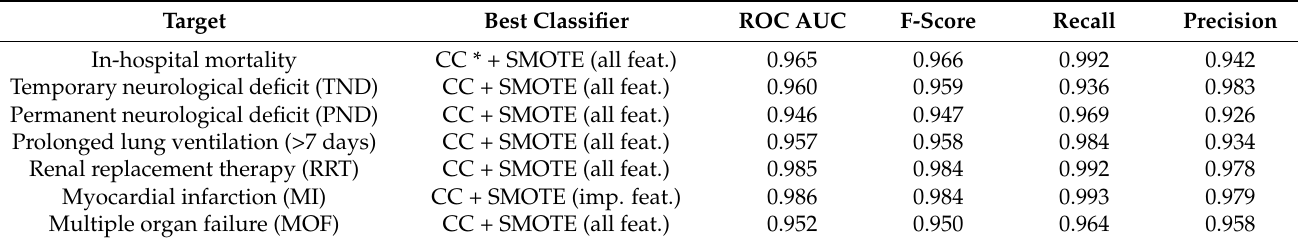
Table 3. Performance of the classifiers for each